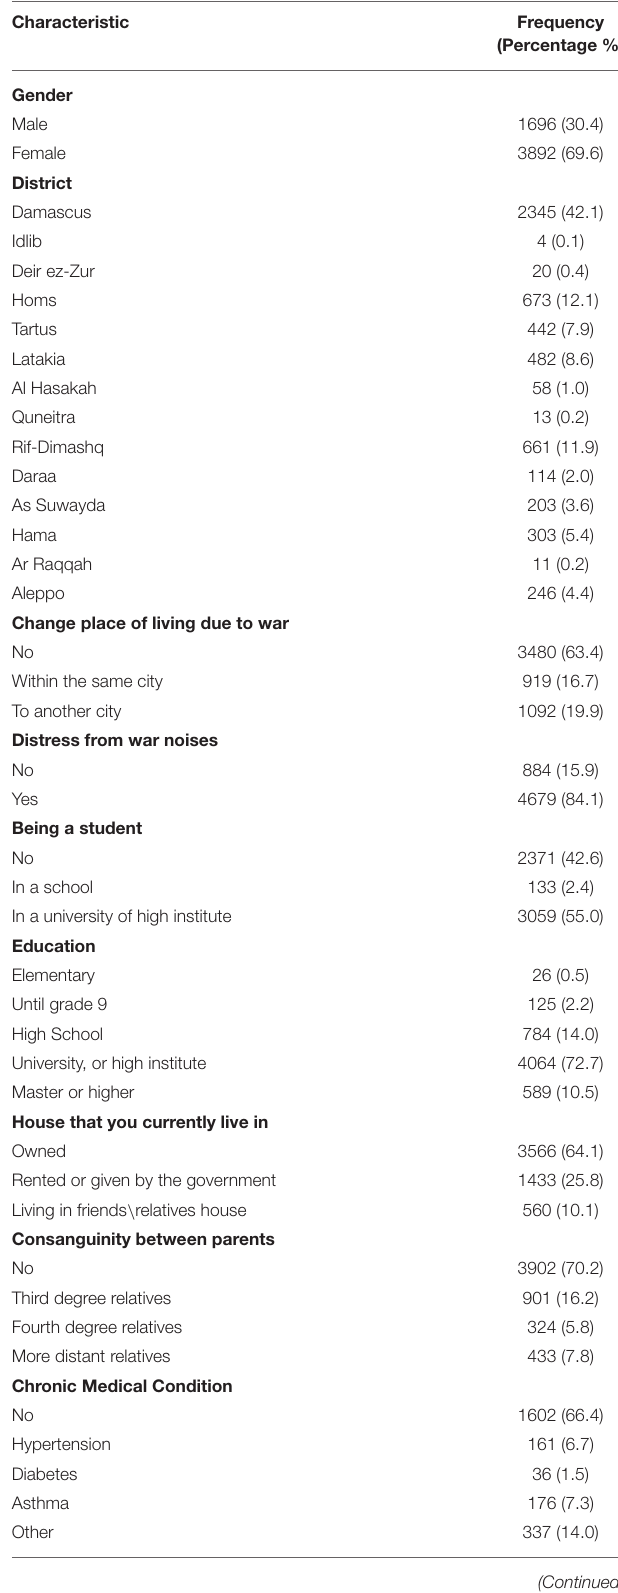
TABLE 1 | Characteristics of responders and their responses to COVID-19